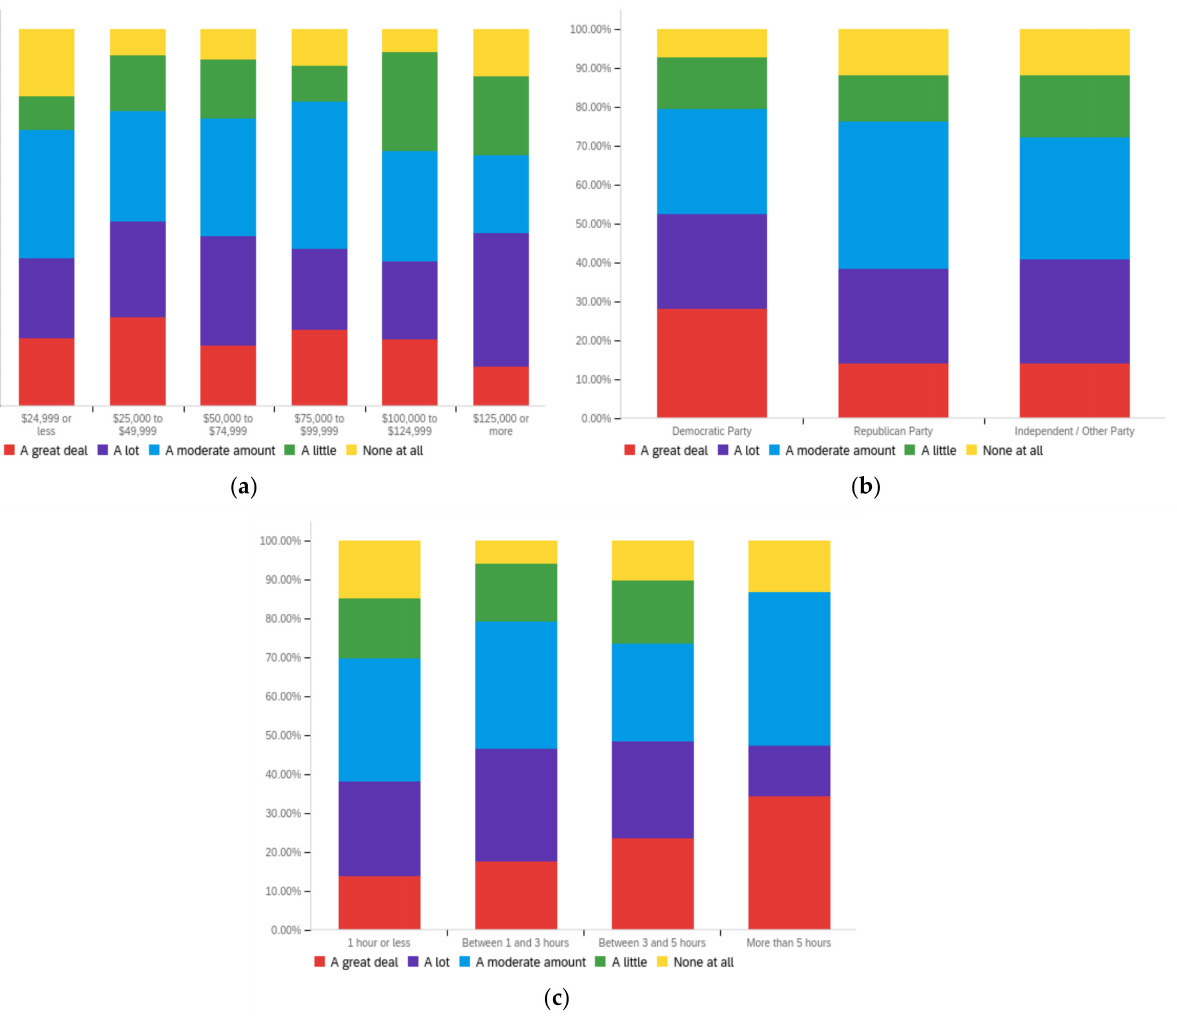
Figure A13. Article sponsor—personal perception impact by: ( a ) income level (top left), ( b ) political affiliation (top right) and ( c ) online usage (bottom).